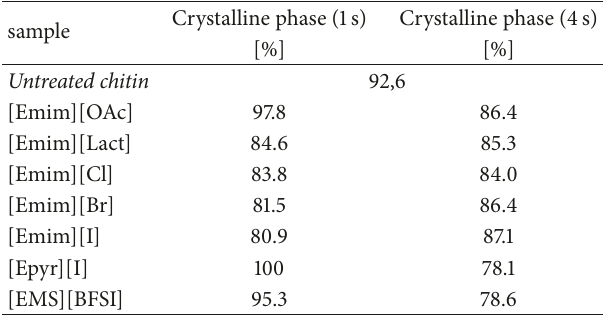
Table 3: Crystallinity of chitin